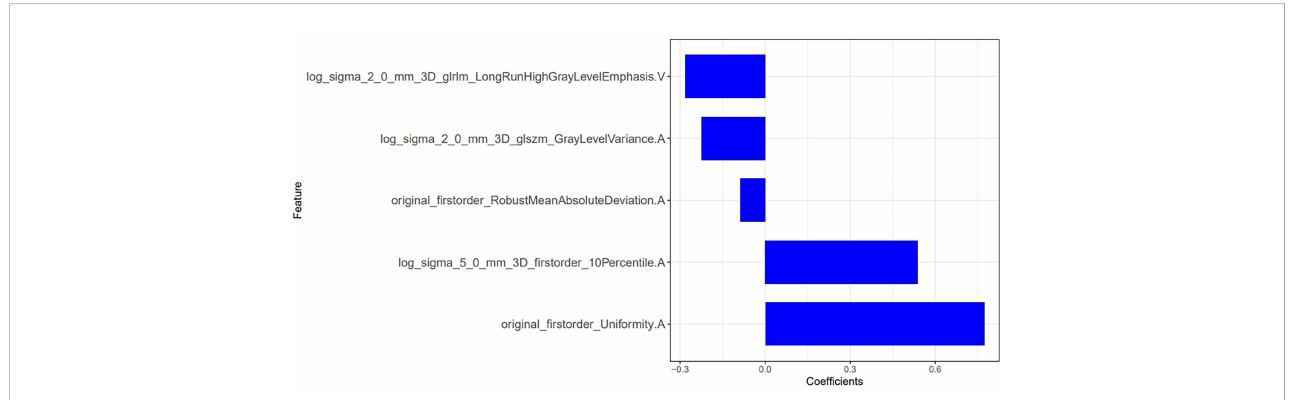
FIGURE 7 Radiomic features screen by model 4 and their